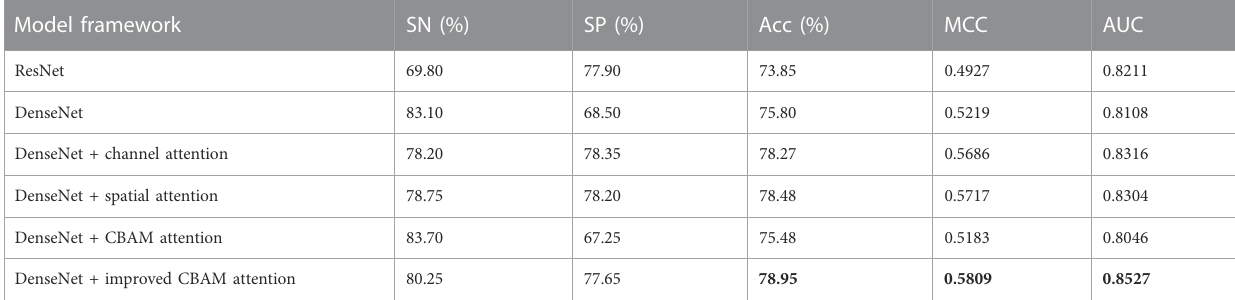
TABLE 4 Comparison with different architecture methods at layer 1 (enhancer recognition). Model